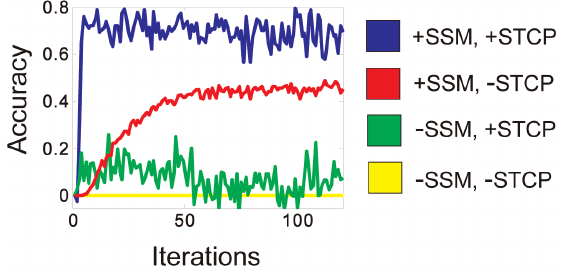
Figure 3. The role of SSM and STCP in the accuracy-trajectory of learning. Synaptic state matching ( + SSM) is crucial for accuracy and long term stability. In the (-SSM) simulation, potentiation was unbounded (e.g. unconstrained by comparison of mean potentiation between the open and closed states). Spike-timing dependent covariance plasticity ( + STCP) substantially improves convergence rate and accuracy as compared to a plasticity rule that is not modulated by spike-rate history (-STCP). In the (-STCP) simulation, D w= + / 2 a . The 40 neuron SSM is trained on two alternating random spike patterns (features), each 40 time-steps long, with an intervening 20 time step quiescent period. Accuracy is a conservative measure of how well internally generated patterns match the missing input during the same time interval. It is defined as one minus the fraction of discordant spikes between the missing input spike trains and the internally generated spike trains. The value here is the average for all forty neurons. Accuracy can be negative in cases where internally generated activity is noisy and/or unstable. The accuracy does not reach maximum (1.0) because the network is unable to generate the earliest part of each random pattern due to the absence of any input during the quiescent period preceding the closed state.